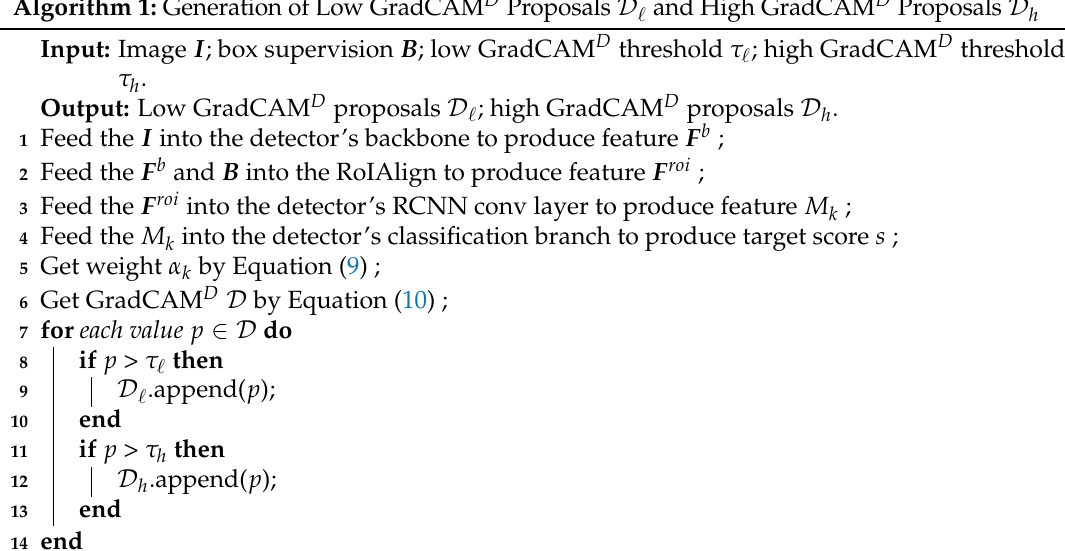
Algorithm 1: Generation of Low GradCAM D Proposals D (cid:96) and High GradCAM D Proposals D